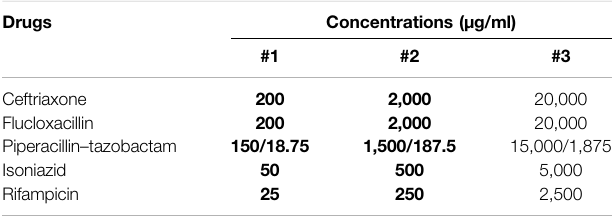
TABLE 1 | Drug concentrations used for LDH assay and fl ow cytometry using the 7-AAD viability stain on lymphocytes.